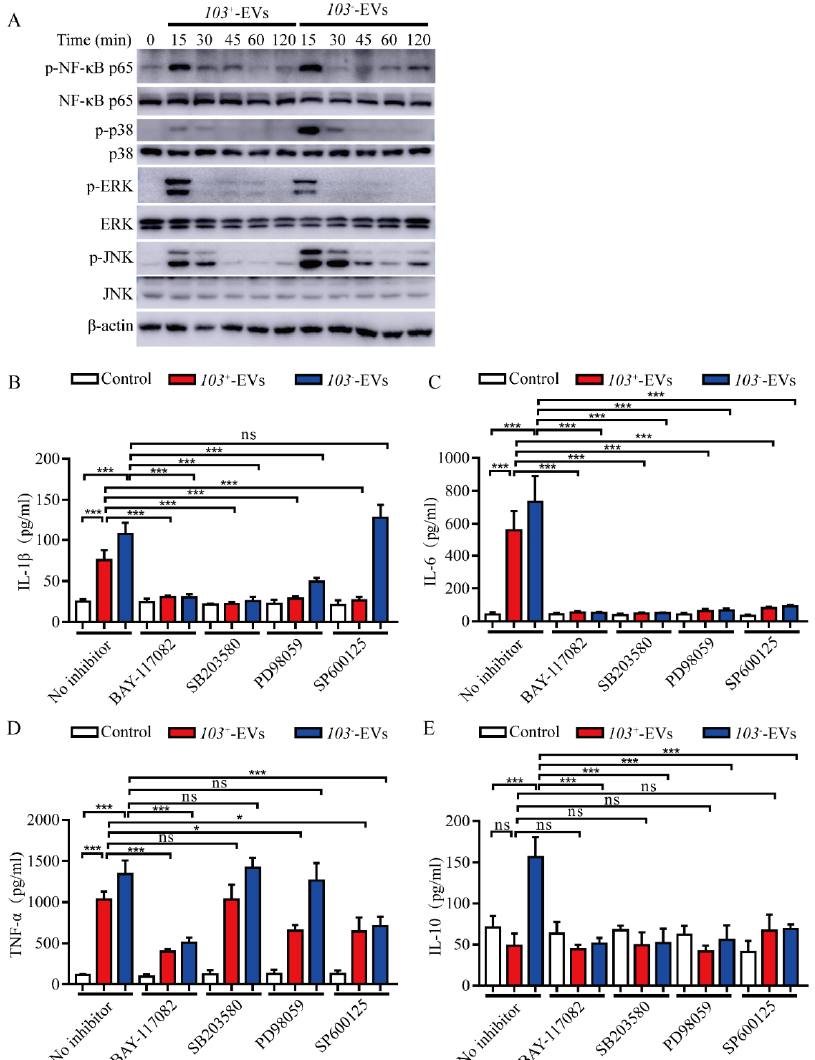
Figure 5. The 103 + ‐ EVs and 103 − ‐ EVs induced inflammatory cytokines secretion was regulated by NF ‐κ B, and MAPK signaling pathways. ( A ) 103 + ‐ EVs and 103 − ‐ EVs induced the phosphorylation of NF ‐κ B p65, p38, ERK and JNK protein in J774A.1 cells. J774A.1 cells were co ‐ incubated with 103 + ‐ EVs or 103 − ‐ EVs at concentrations of 5 μ g/mL for 0 min (control), 15 min, 30 min, 45 min, 60 min, and 120 min, the phosphorylated and total protein of NF ‐κ B p65, p38, ERK and JNK were detected by western blotting. The concentrations of ( B ) IL ‐ 1 β , ( C ) IL ‐ 6, ( D ) TNF ‐α , and ( E ) IL ‐ 10 in the culture supernatants. The inhibitors of NF ‐κ B (BAY ‐ 117082, 10 μ M), p38 (SB203580, 10 μ M), ERK (PD98059, 20 μ M), and JNK (SP600125, 20 μ M) were used to pretreat for 2 h before stimulation J774A.1 cells with 103 + ‐ EVs or 103 − ‐ EVs at concentrations of 5 μ g/mL for 24 h, and then collected supernatants. The data were compared with the no inhibitor stimulated control cells. The comparisons between groups were performed by one ‐ way ANOVA followed by Tukey’s test. * p < 0.05, *** p < 0.001, and ns, not significant.